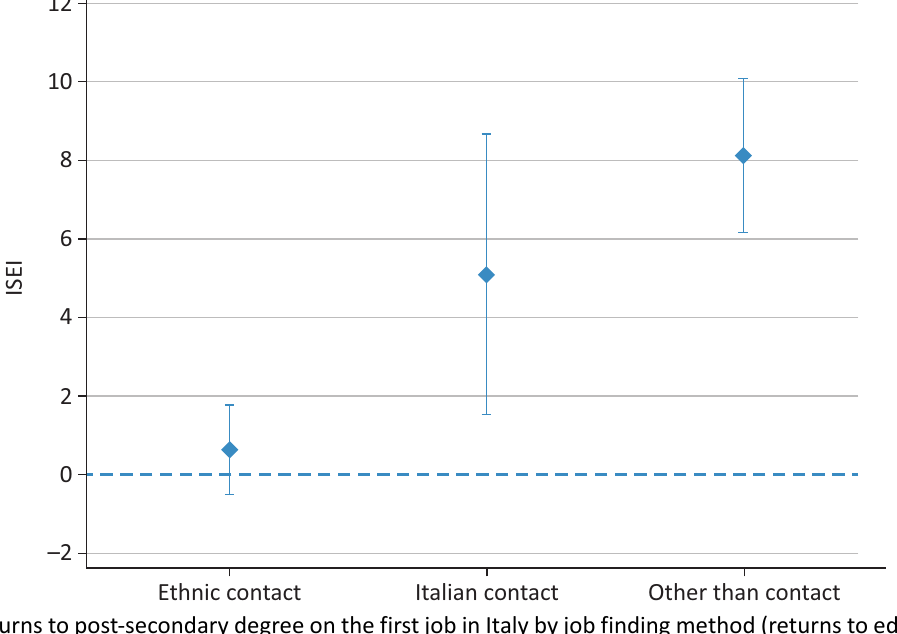
Figure 3. ISEI returns to post-secondary degree on the first job in Italy by job finding method (returns to education by area and other controls included, 95% C.I.). Table 1. Factors affecting the ISEI of the first job in Italy (returns to education by area and by job finding method included).